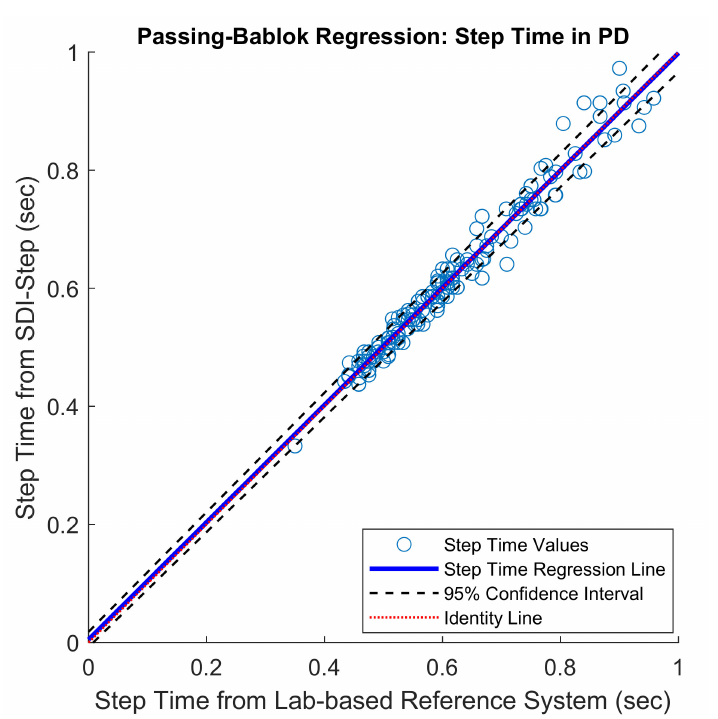
Figure 3. Scatter plots with Passing–Bablok regression line (blue) along with 95% confidence interval (black dashed line) and identity line (indicated by a red line) for step time values obtained from people with PD. PB-slope (95% CI): 1.0 (1–1.16), and PB-Intercept (95% CI): 0 ( − 0.09–0).